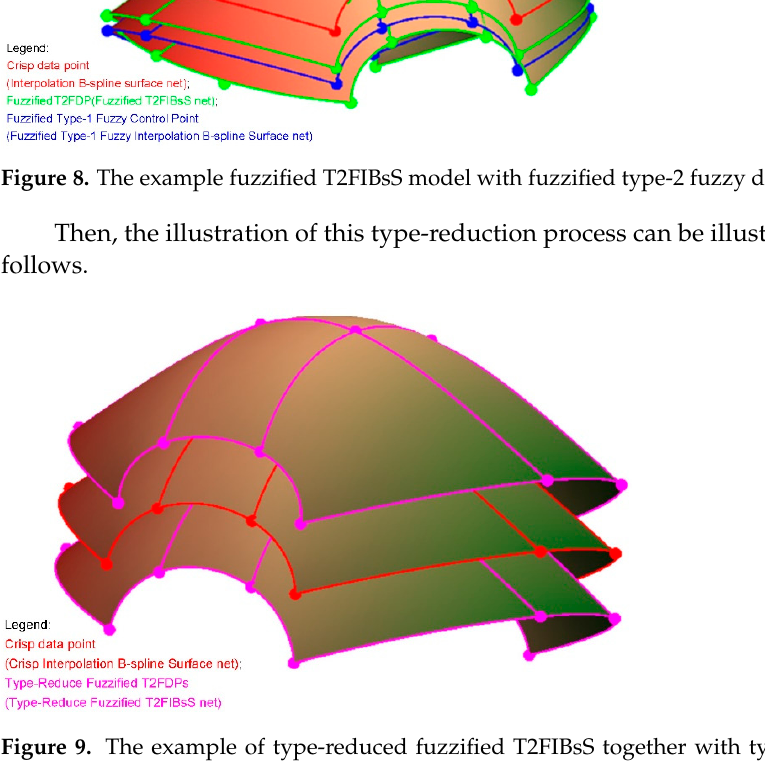
Figure 9. The example of type-reduced fuzzified T2FIBsS together with type-reduced fuzzified T2FDPs net.